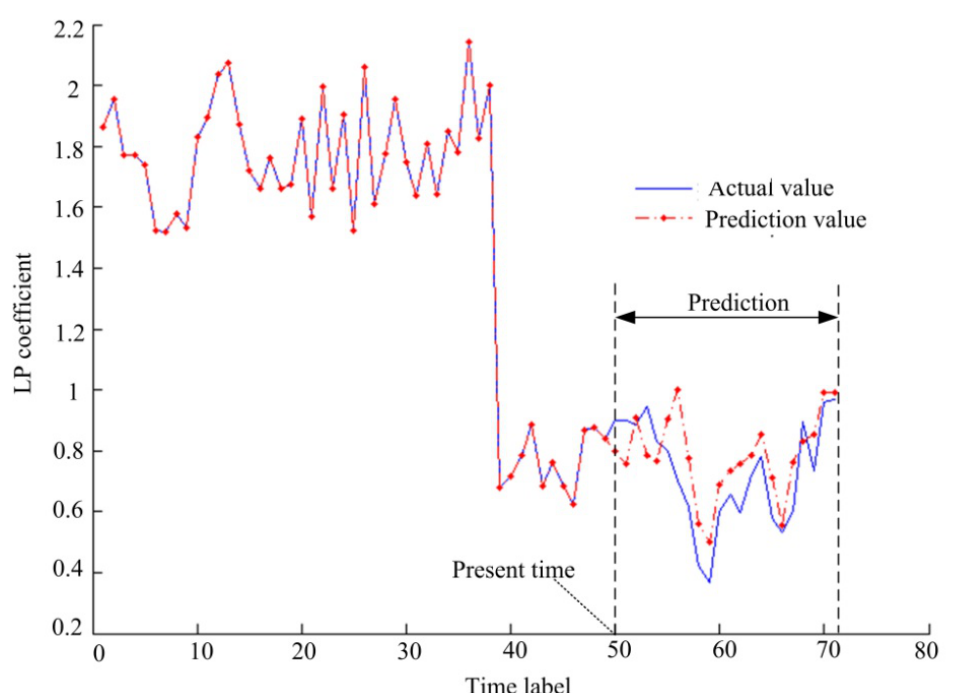
Figure 10. The prediction result of the first dimension of the feature vectors based on the